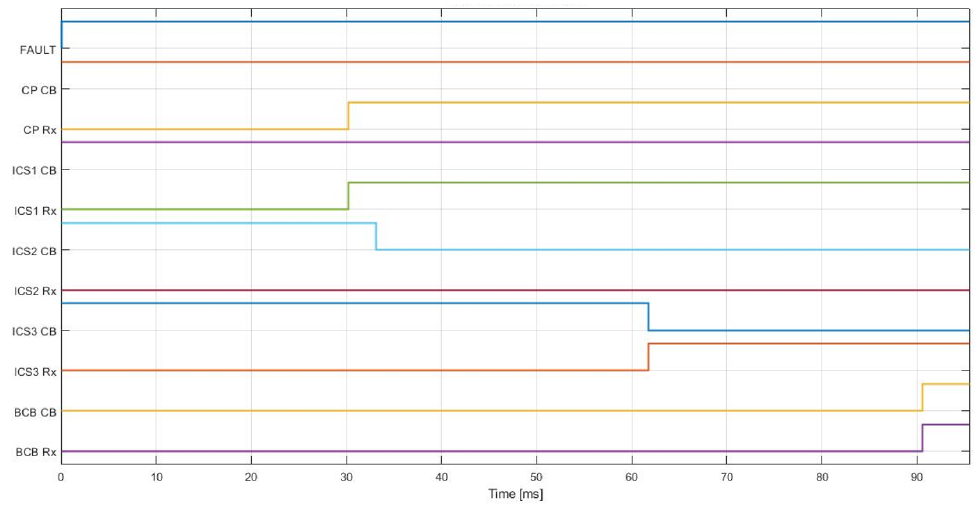
Figure 4. Digital signals acquired during a fault between ICS2 and